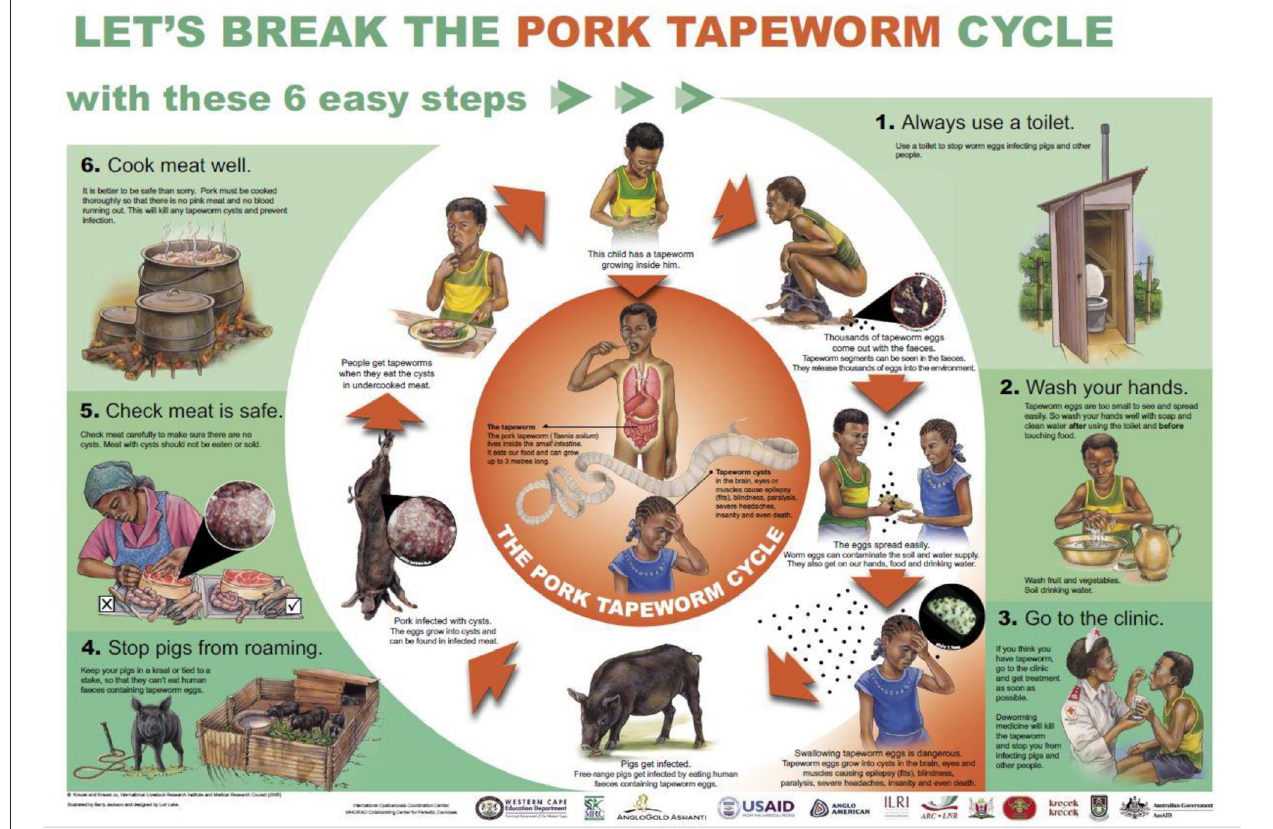
FIGURE 2 | The “let’s break the pork tapeworm life cycle” poster: source